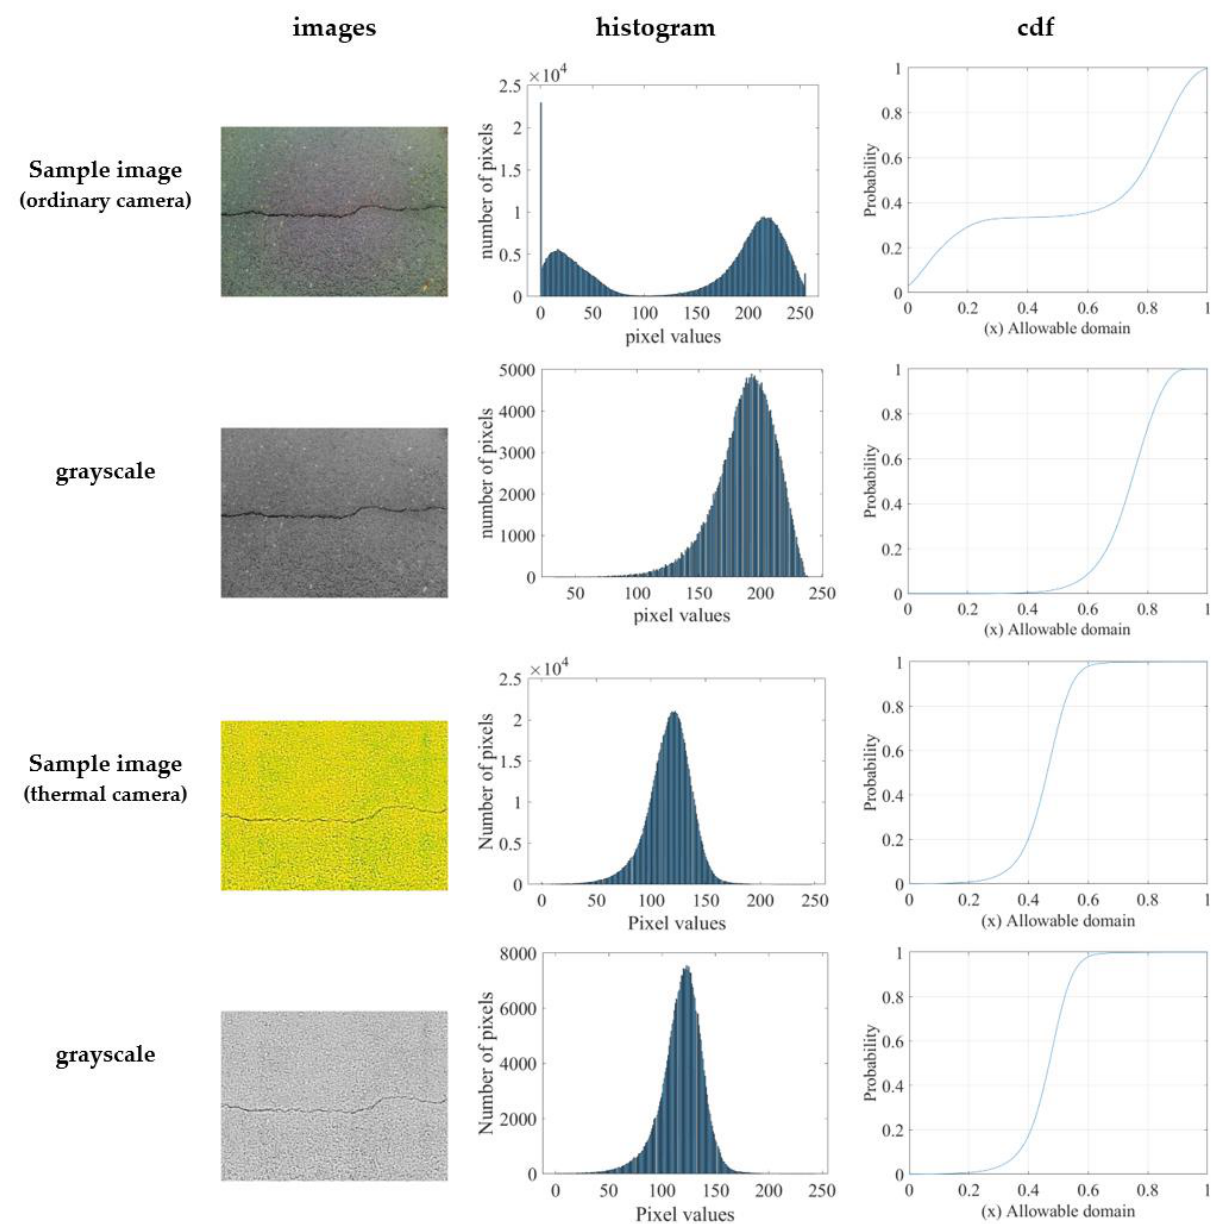
Figure 2. Histogram and CDF comparison on both sample images (taken from an ordinary camera and a thermal camera, respectively).